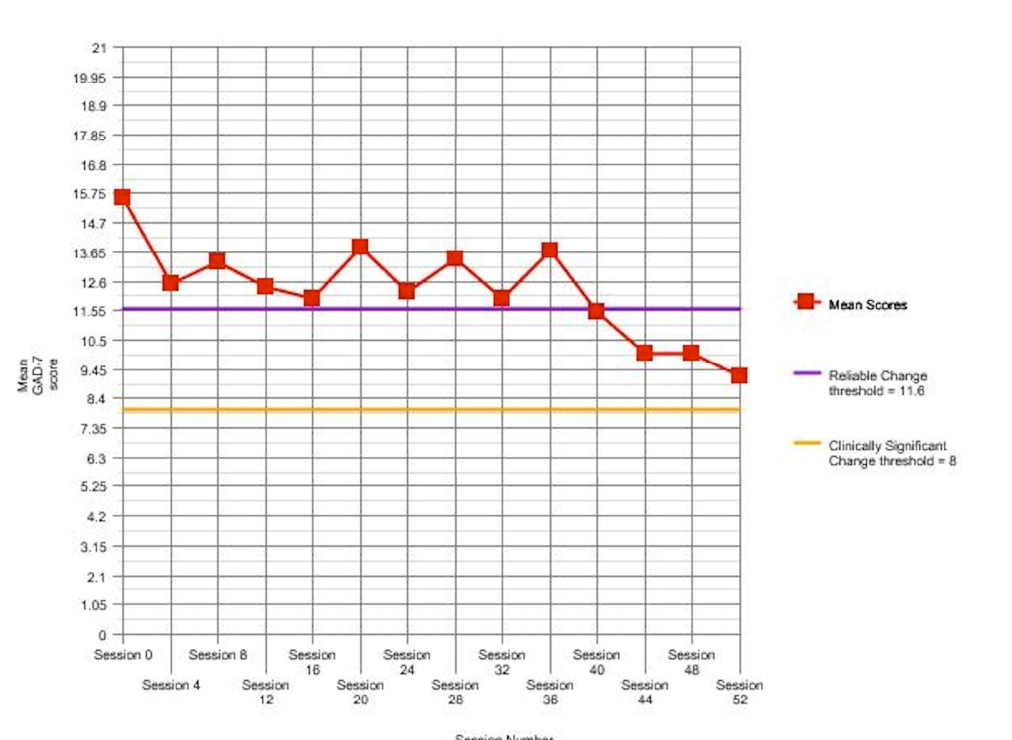
Figure 9: Mean GAD-7 score: all